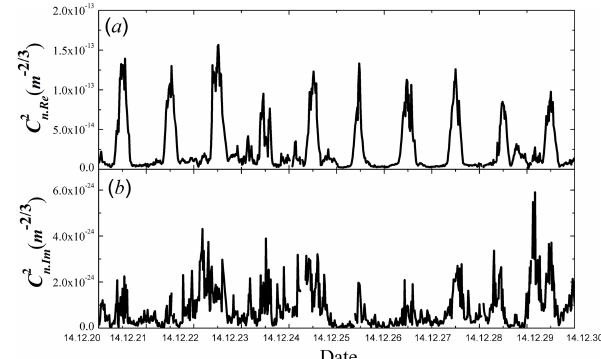
Figure 3. Temporal variations in the aerosol mass concentration M a (a) and visibility L v (b) observed during 20–29 December 2014.